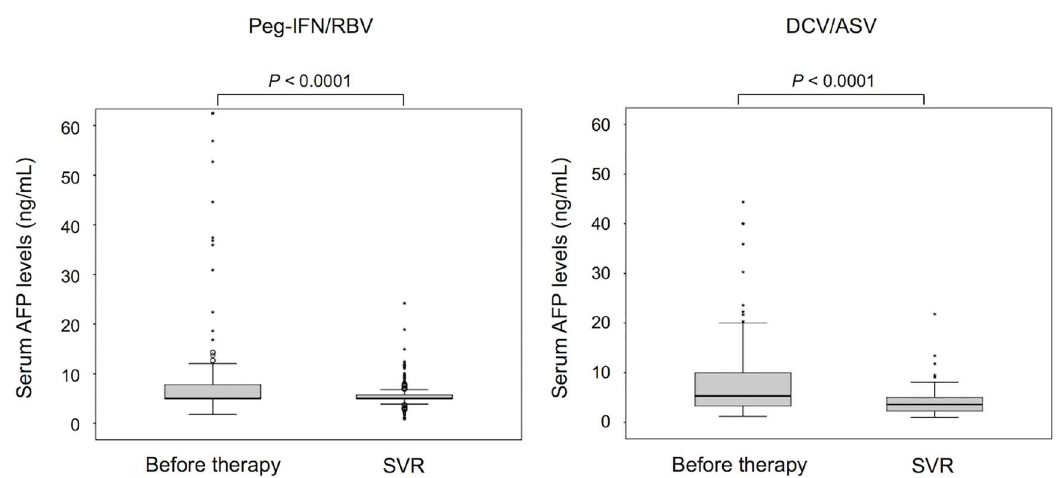
Fig 3. Sequential changes of serum alfa-fetoprotein (AFP). Serum AFP levels before therapy and six months after the end of the treatment in patients treated with peg-interferon plus ribavirin (PEG-IFN/RBV) or daclatasvirplus asunaprevir (DCV/ASV). In these box-and-whisker plots, lines within the boxes represent medianvalues; the upper and lower lines of the boxes represent the 75th and 25th percentiles, respectively; the upper and lower bars outside the boxes represent the 90th and 10th percentiles,